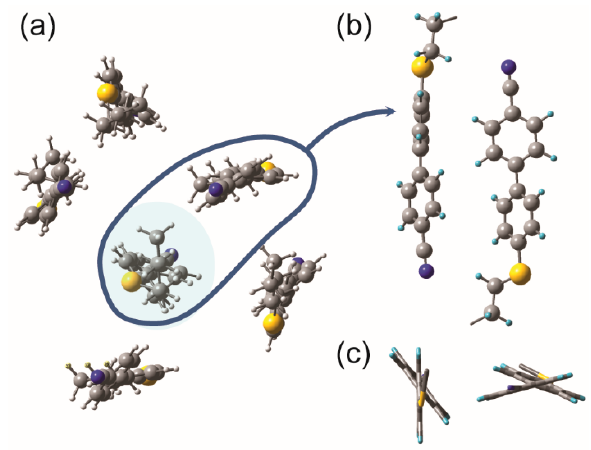
Figure 3. View of the CBSC7 monomer components. ( a ) Top view (X-Y plane) of the system with the initial arrangement of six molecules into a sublayer prepared for DFT calculations. IR spectra were calculated for a molecule (highlighted in blue) that is surrounded by other molecules. ( b ) The close-up view of a CBSC7 molecule pair after optimization using the B3LYP/6-311 G (d, p) method. ( c ) Top view (X-Y plane) of a pair of molecules (stick representation of the bonds).